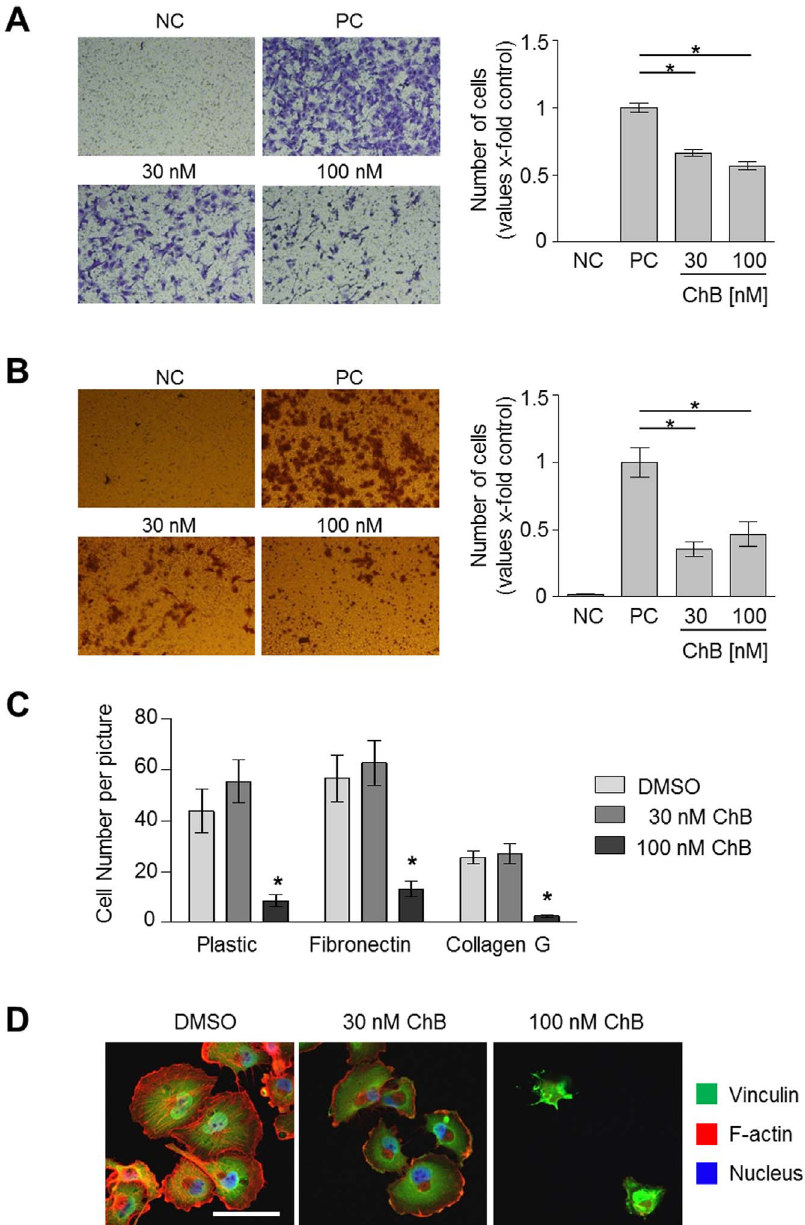
Figure 3. Treatment with Chondramide reduces breast cancer cell migration, invasion and adhesion. (A) Chondramide treated and untreated MDA-MB-231 cells were allowed to migrate in a Boyden chamber for 16 h. (B) Chondramide inhibits invasion of MDA-MB-231 cells through matrigel in Boyden chamber (48 h). A,B: For positive control (PC) lower compartment was filled with medium plus 10% FCS, for negative control (NC) only medium without FCS was added. *, p , 0.05 One-way ANOVA, Tukey post-test, n=3. (C) Pretreated MDA-MB-231 cells were seeded freshly on indicated surfaces and counted after fixation. *, p , 0.05 One-way ANOVA, Tukey post-test, n=3. (D) Cells from C were stained for F-actin, nuclei and vinculin. Bar represents 50 m